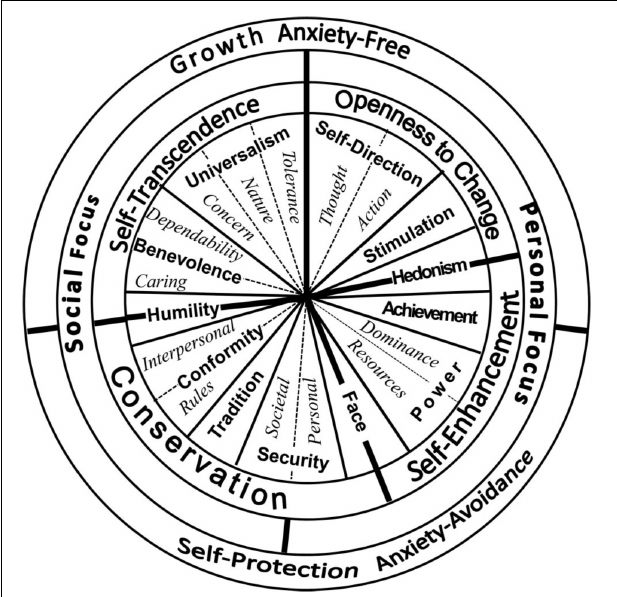
FIGURE 1 | Motivational continuum of the basic human values. Adapted from Schwartz et al. (2012). Copyright 2012 by the American Psychological Association. Reproduced with